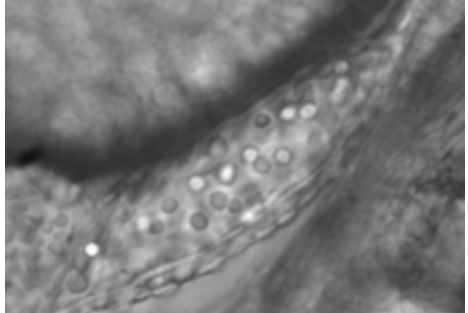
Fig. 4: The embryonic heart tube of a Zebrafish 30 hours post fertilization (hpf), courtesy of [43]. Spherical blood cells are seen within the tubular heart. The heart tube is roughly 5 blood cells thick in